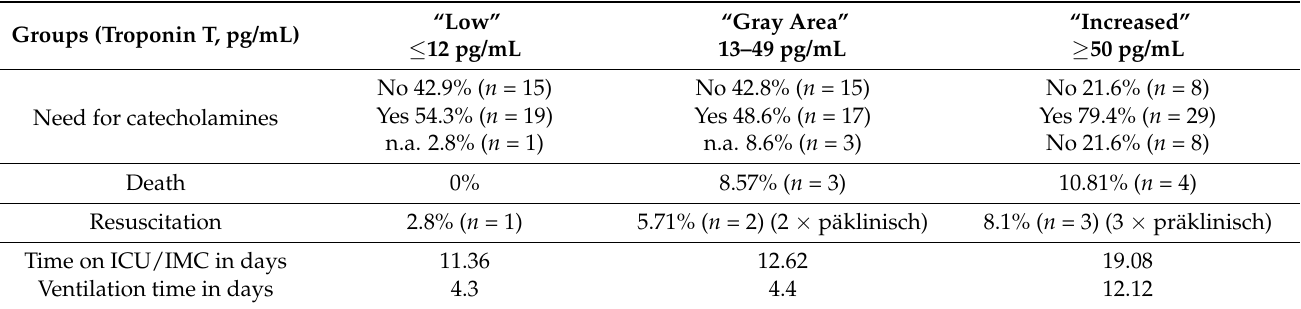
Table 2. Polytrauma patients’ outcome, Troponin T subgroups.